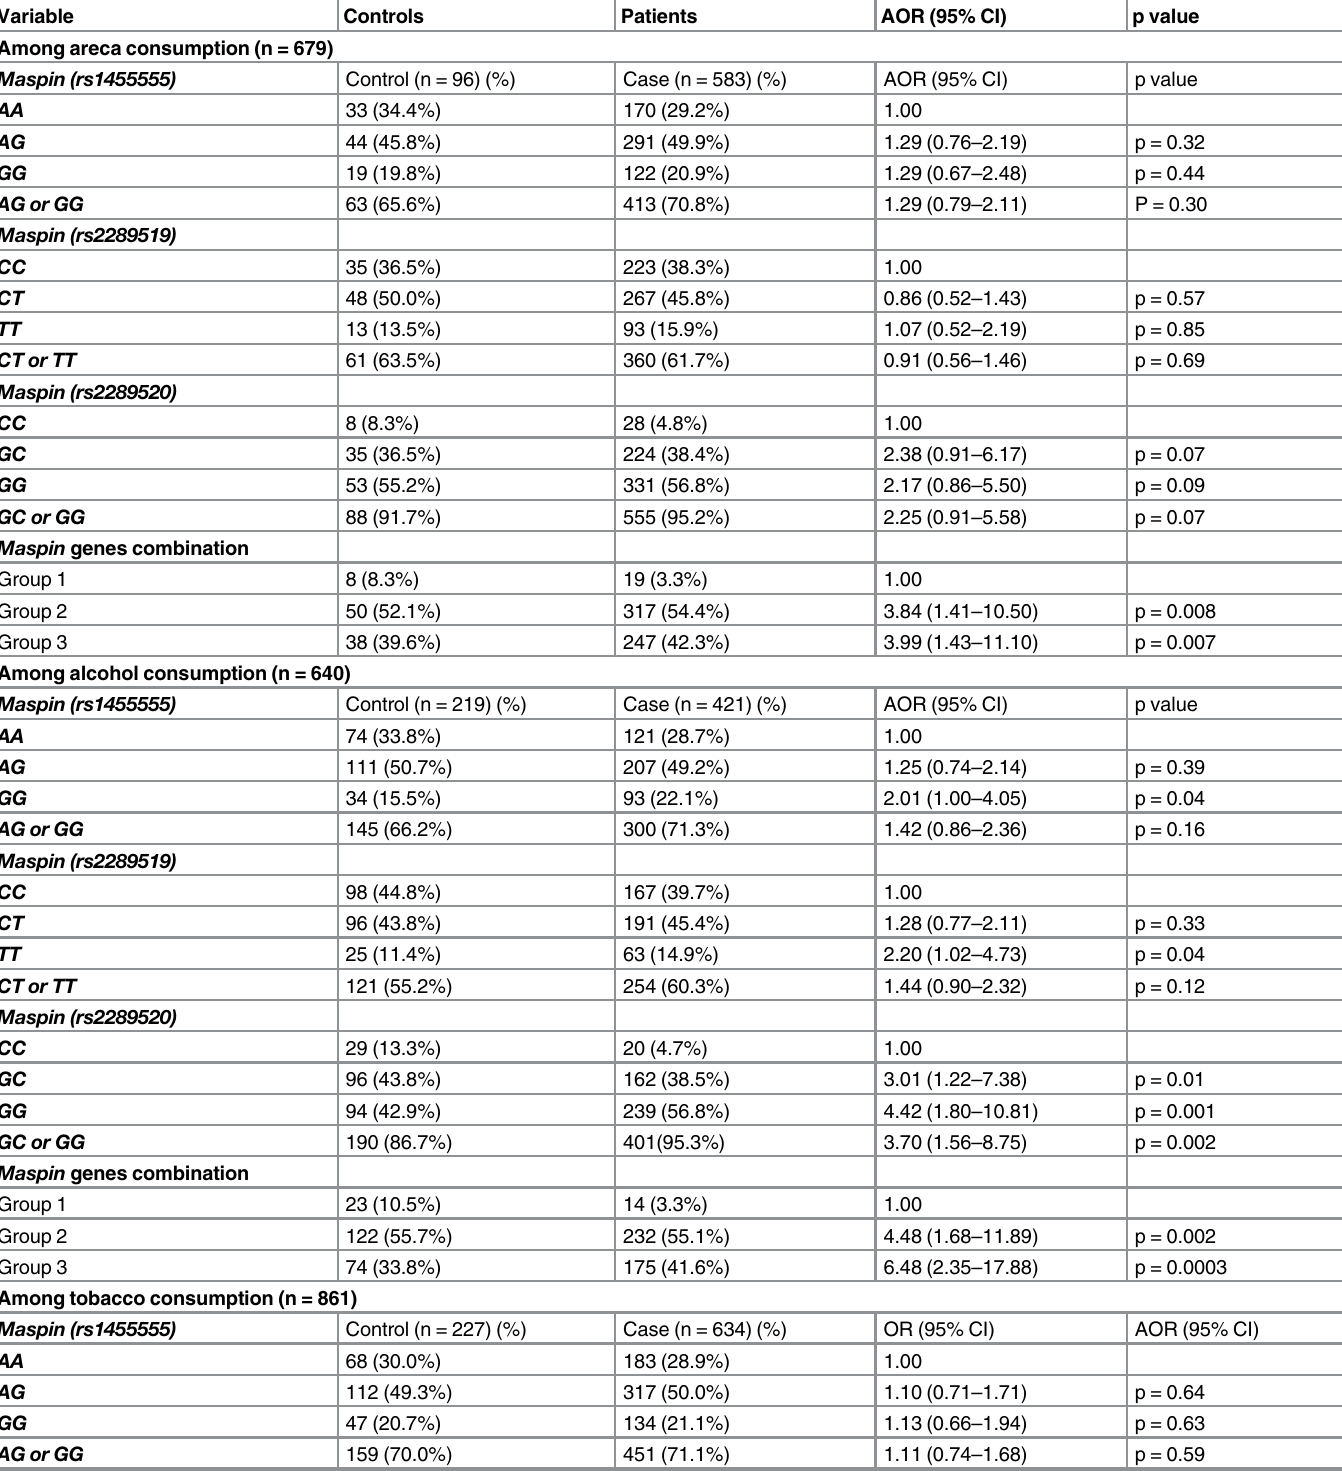
Table 4. Adjusted odds ratio (AOR) and 95% confidence intervals (CIs) of oral cancer associated with genotypic frequencies of Maspin among individuals exposure to related environmental risk